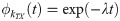
mRNA number frequency spectrum of gene expression network model with super-Poisson active gene transcription dynamics.(A) Gene expression network model with the vibrant active gene transcription process. The active gene transcription rate, kTX, is a dynamic, stochastic variable. The mean value, 〈kTX〉, of the active gene transcription rate is the same as the value of kTX in Fig 3. The normalized time correlation function (TCF) of kTX is given by an exponentially decaying function of time, i.e., ϕkTX(t)=exp(−λt). An example of a reaction scheme with the exponential TCF of the rate fluctuation is a two-channel reaction model (see Fig 1B and 1F). Gene regulation by the promoter is modeled the same as Model II in Fig 3B. (B) Dependence of the mRNA number frequency spectrum (middle) and the mean-scaled frequency spectrum of the transcription rate (right) on the lifetime distributions of inactive gene state with the same mean but different shape parameters (left). The values of the relaxation rate, λ, and the relative variance, ηkTX2, of the fluctuation of kTX are set to be 0.01 min-1and 0.1, respectively. (lines) The theoretical results for the mRNA number frequency spectrum calculated by Eqs 3 and 11. (circles) Stochastic simulation results (see Supporting Information, S8 Text). (C) Dependence of the mRNA number frequency spectrum on λ for three different values of ηkTX2. (surface) The theoretical result. (spheres) Stochastic simulation results. The mRNA number frequency spectrum has a peak around the promoter fluctuation frequency ωpeak = 2π/(τon+τoff)≅0.1 rad∙min−1, originating from the sub-Poisson gene regulation dynamics of the promoter. The peak diminishes when ηkTX2 is large and kTX fluctuates quickly. (D) Three components of the frequency spectrum of the transcription rate. (black line) the value of SRTX(ω)/(2〈RTX〉)[=〈RTX〉S˜RTX(ω)/2] or Sm(ω)/Sm0(ω)−1 with Sm0(ω)=2(〈m〉γm)/(ω2+γm2). The value of λ is set to be 0.01 min−1. (colored lines) three components of the frequency spectrum: Sξ(ω) originating from the gene regulating dynamics of the promoter (blue), SkTX(ω) originating from the active gene transcription dynamics (red), and their convolution Sξ(ω)*SkTX(ω) (green). See Eq 11. The relative contribution of SkTX(ω) and Sξ(ω)*SkTX(ω) increases with ηkTX2, while Sξ(ω) does not. When the value of ηkTX2 is 10, the relative contribution of Sξ(ω) is marginal, but the non-monotonic peak of the frequency spectrum persists due to the contribution of the convolution term, Sξ(ω)*SkTX(ω), given that λ is smaller than ωpeak (see S3 Fig for the case where λ is as large as ωpeak).